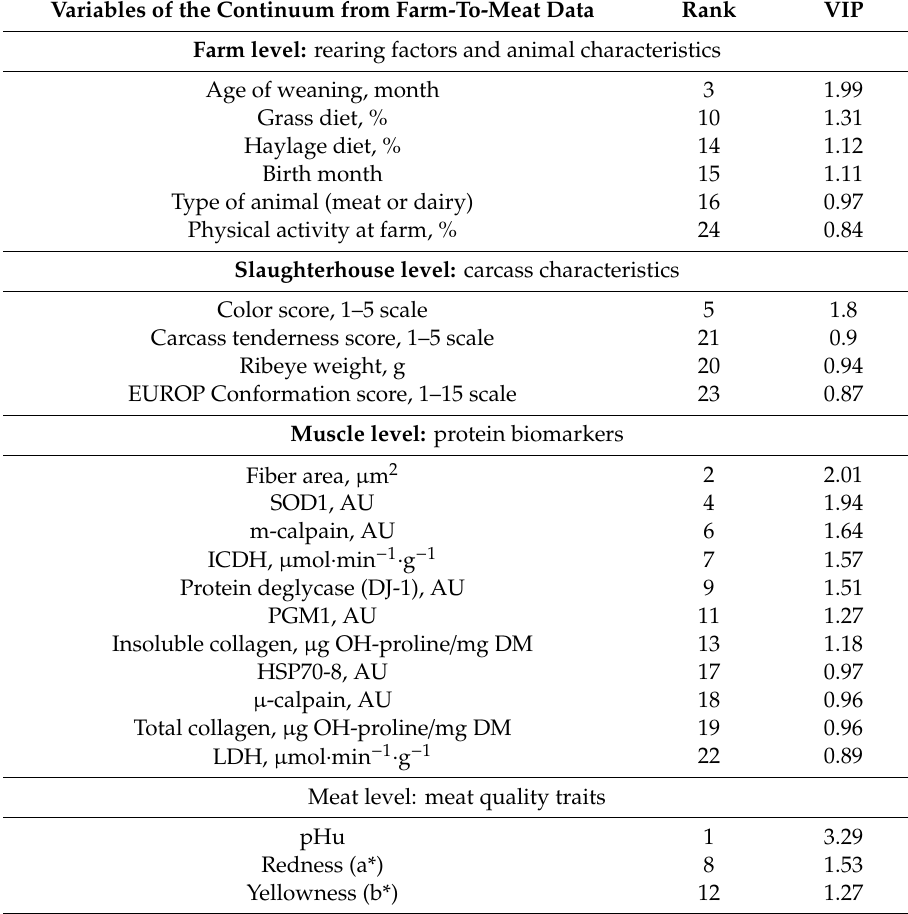
Table 5. Best Partial Least Squares (PLS) model of Warner-Bratzler Shear force (WBSF) showing the ranking of the 24 retained variables from the continuum data from farm-to-meat and their variable importance in the projection (VIP)